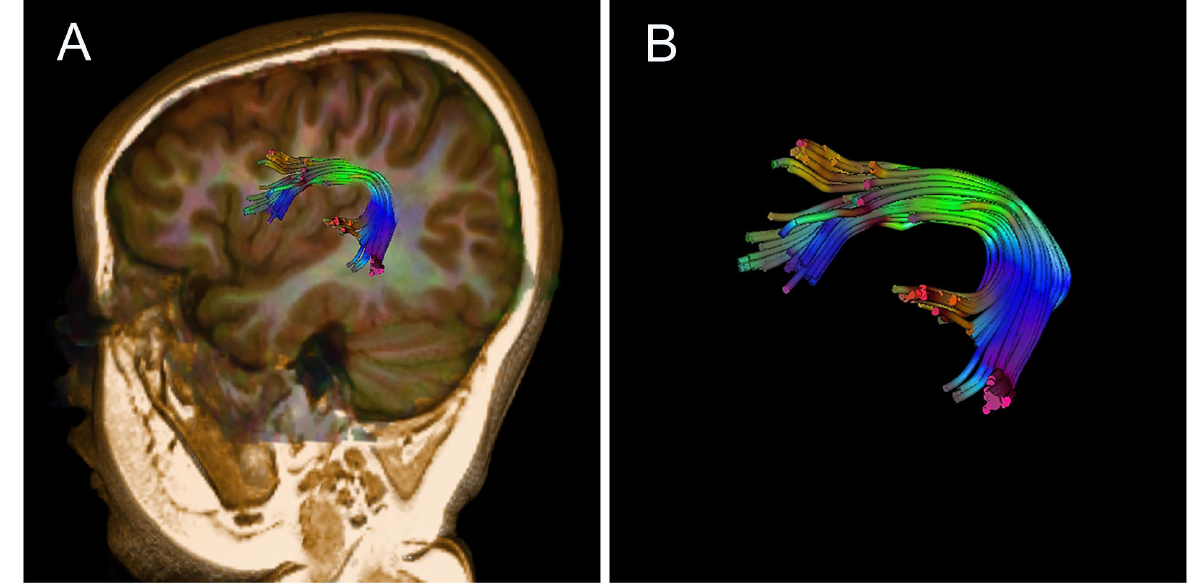
Figure 2. (A) 3-dimensional (3D) tract reconstruction of AF is superimposed on a sagittal T1 volume. (B) 3D render